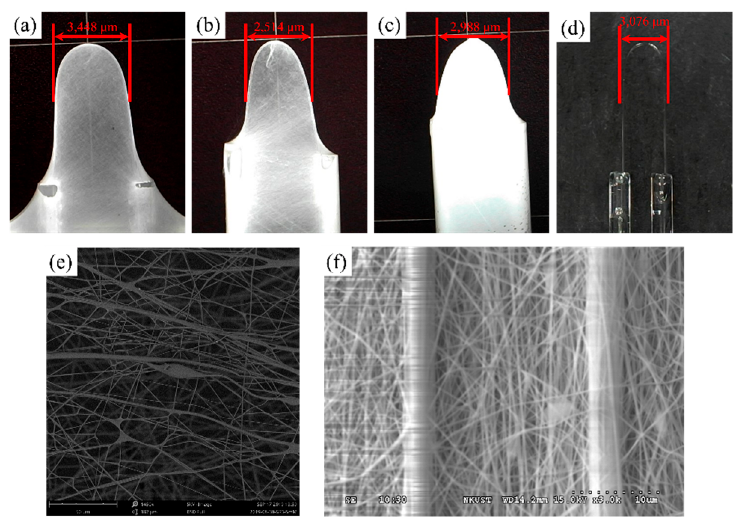
Figure 3. Electrospun U-shaped optical fiber products formed under different electrospinning du- rations ( a ) 5 min, diameter = 3448 μ m; ( b ) 10 min, diameter = 2514 μ m; ( c ) 15 min, diameter = 2988 μ m; ( d ) optical microscope (OM) image for the bar U-shaped fiber; ( e ) SEM im-age for electrospun fibers; ( f ) SEM image to show the fiber morphology after the electrospun PVA fibers.